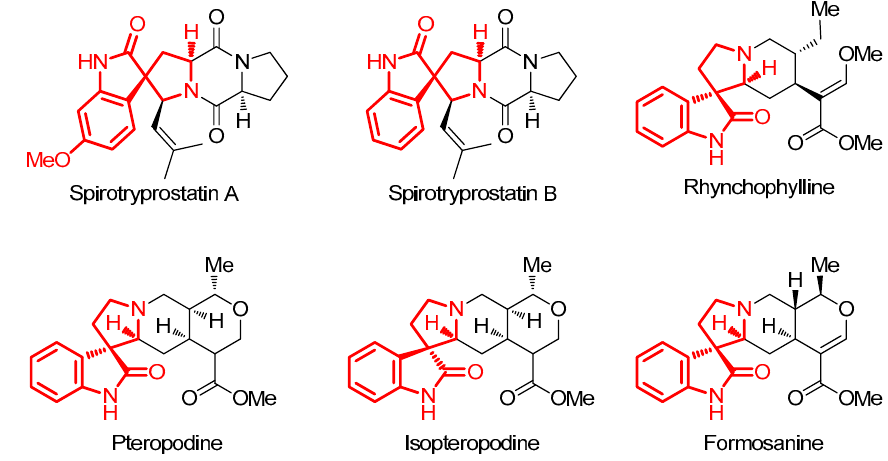
Figure 5. Spirotryprostatins A and B [89], pteropodine and isopteropodine [90], rhynchophylline [91] and formosanine [92].